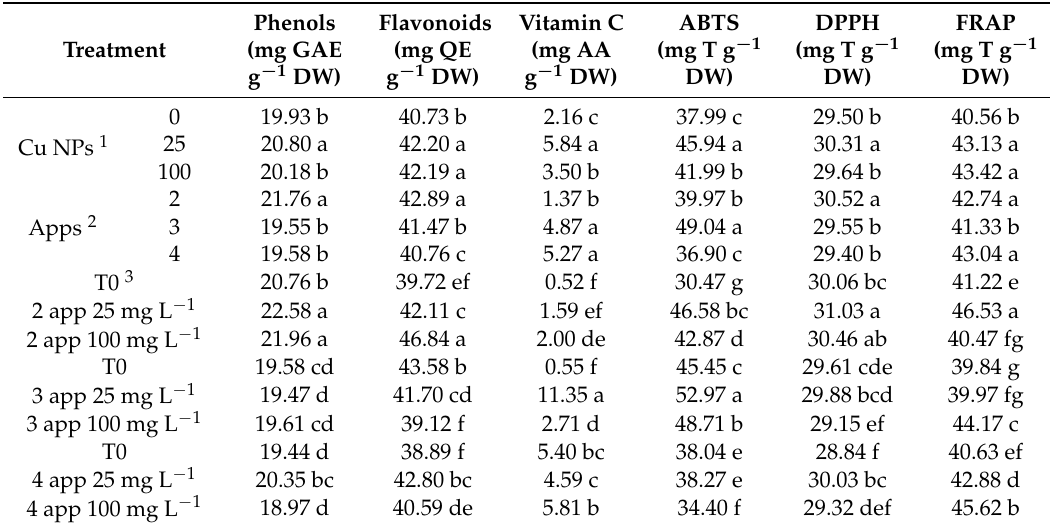
Table 1. Antioxidant content in leaves of Moringa oleifera